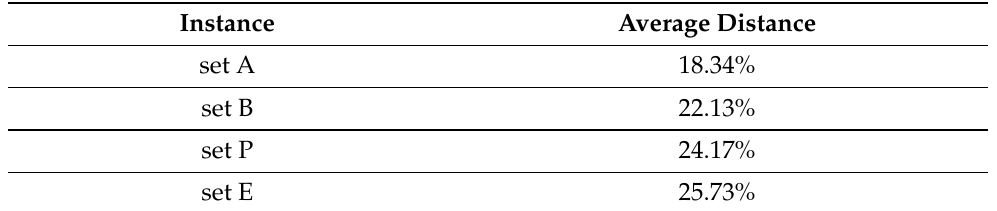
Table 8. Mutation domination experiment—averaged results from all examples, grouped by instance sets.